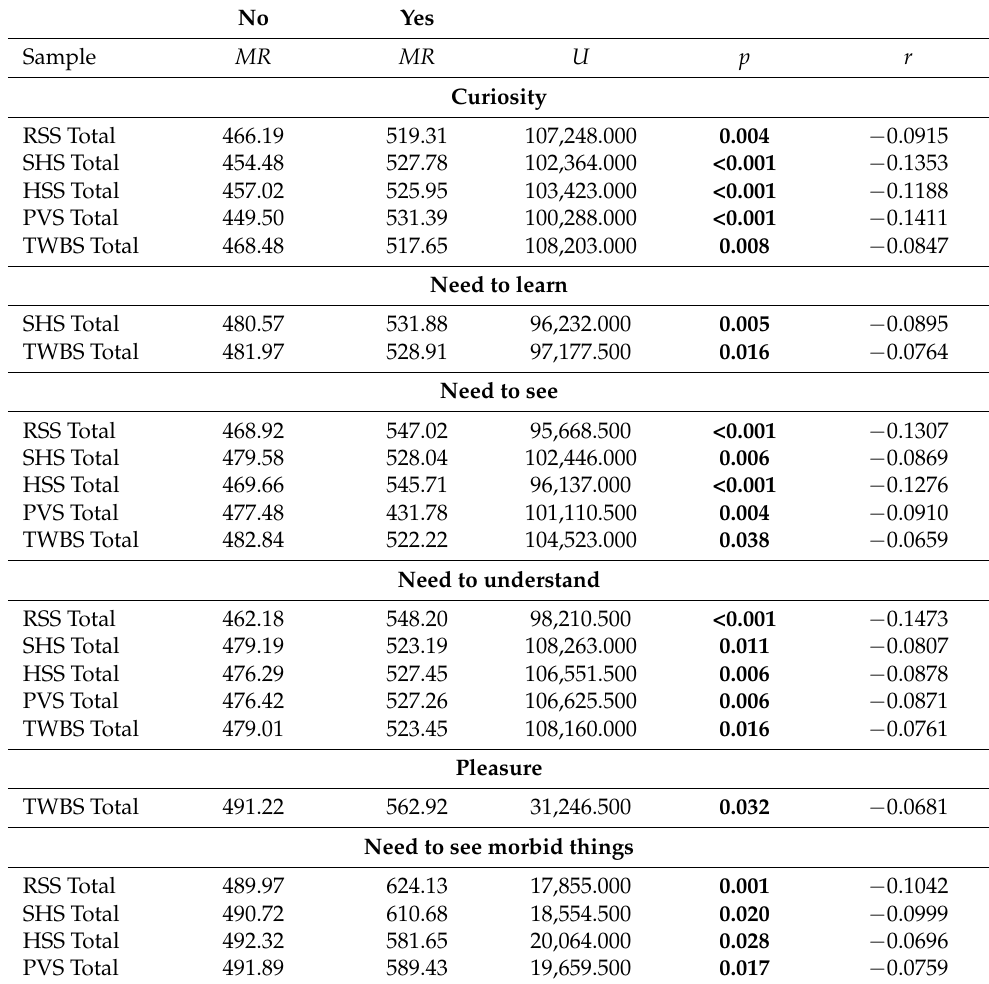
Table 7. Rumination on sadness (RSS), self-hatred (SHS), hostility (HSS), psychological vulnerability (PVS), and tourism wellbeing (TWBS) frequencies and differences according to dark tourism motives. No Yes Sample